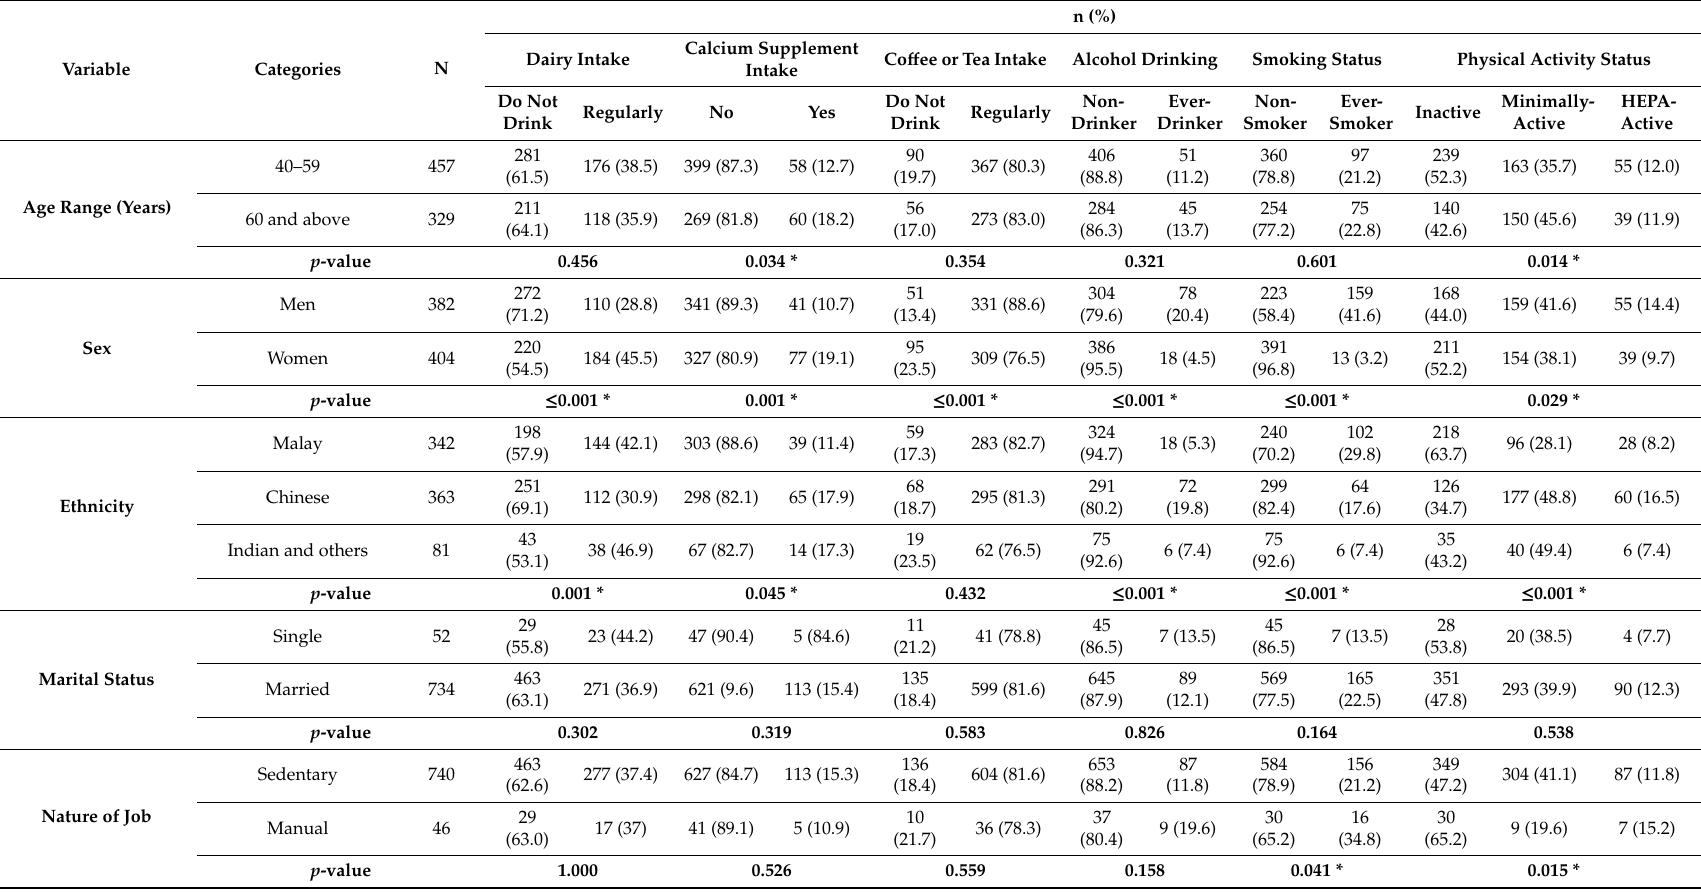
Table 4. Comparison of osteoprotective practices with sociodemographic